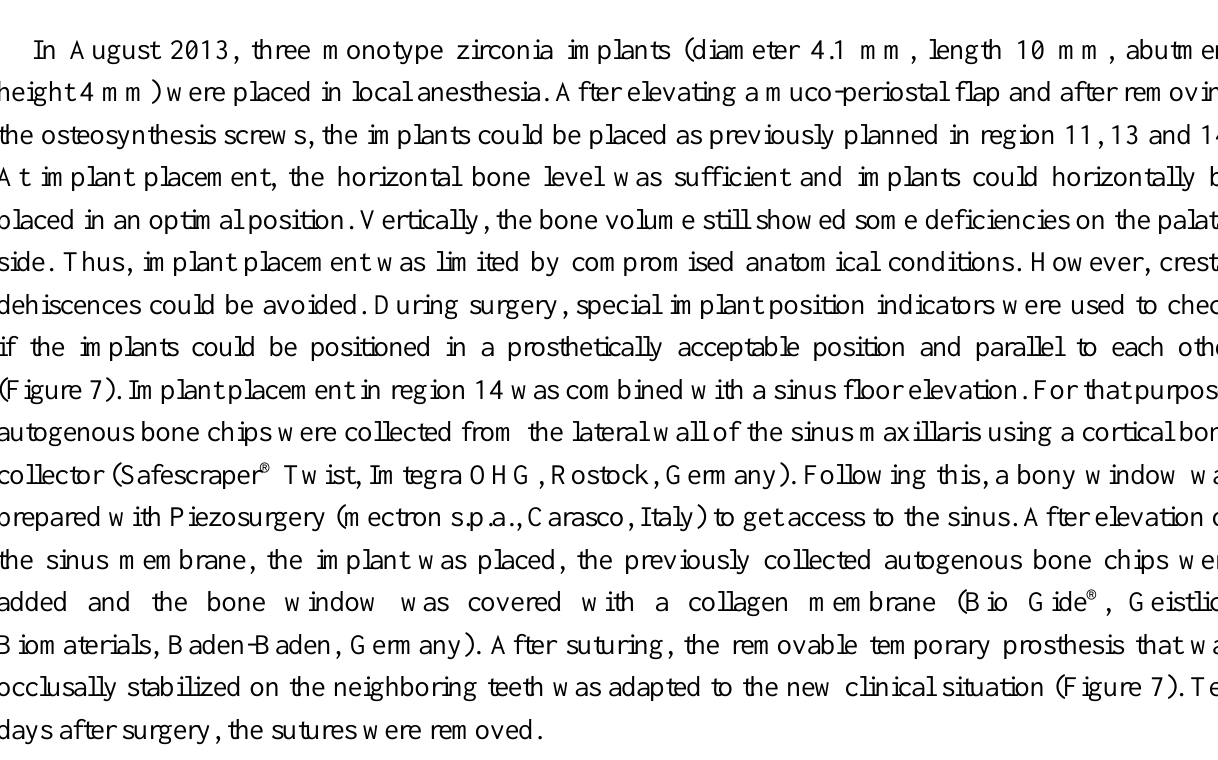
Figure 6. Cone-beam CT-Scan with radiographic stent in situ at six months after bone augmentation. Sagittal CT-images representing region 11 ( A ); 13 ( B ) and 14 ( C ). Sufficient vertical and horizontal bone volume in region 11 and 13 ( A , B ), reduced horizontal bone volume in region 14 ( C ). Images: Institute of Radiology, Kantonsspital Aarau, AG, Aarau,